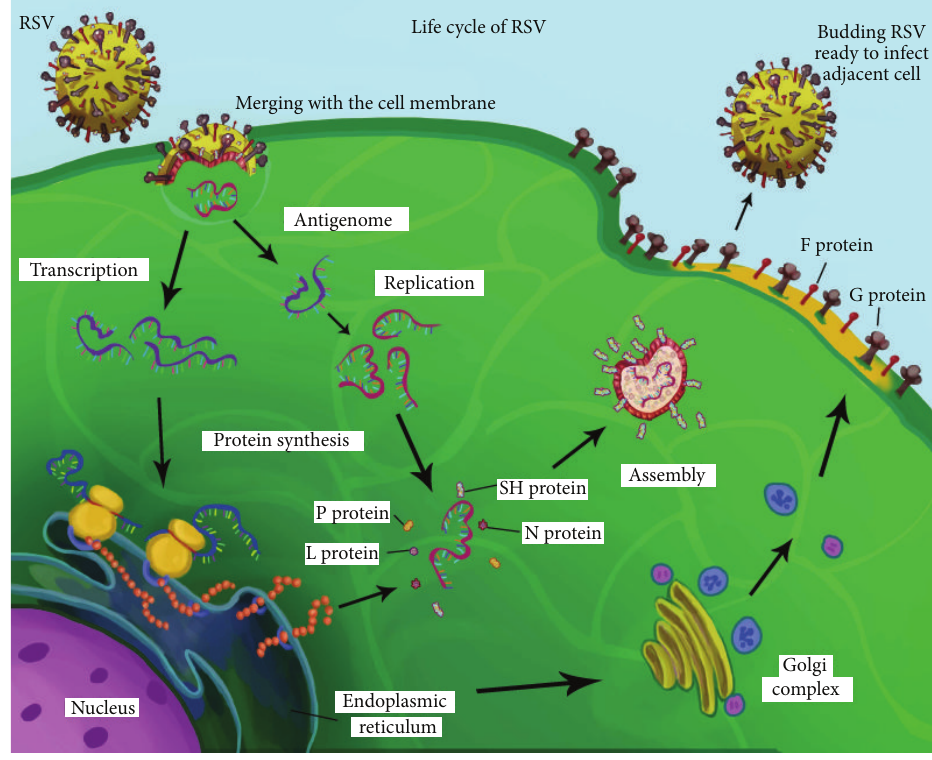
Figure 4: A schematic representation of RSV life cycle.